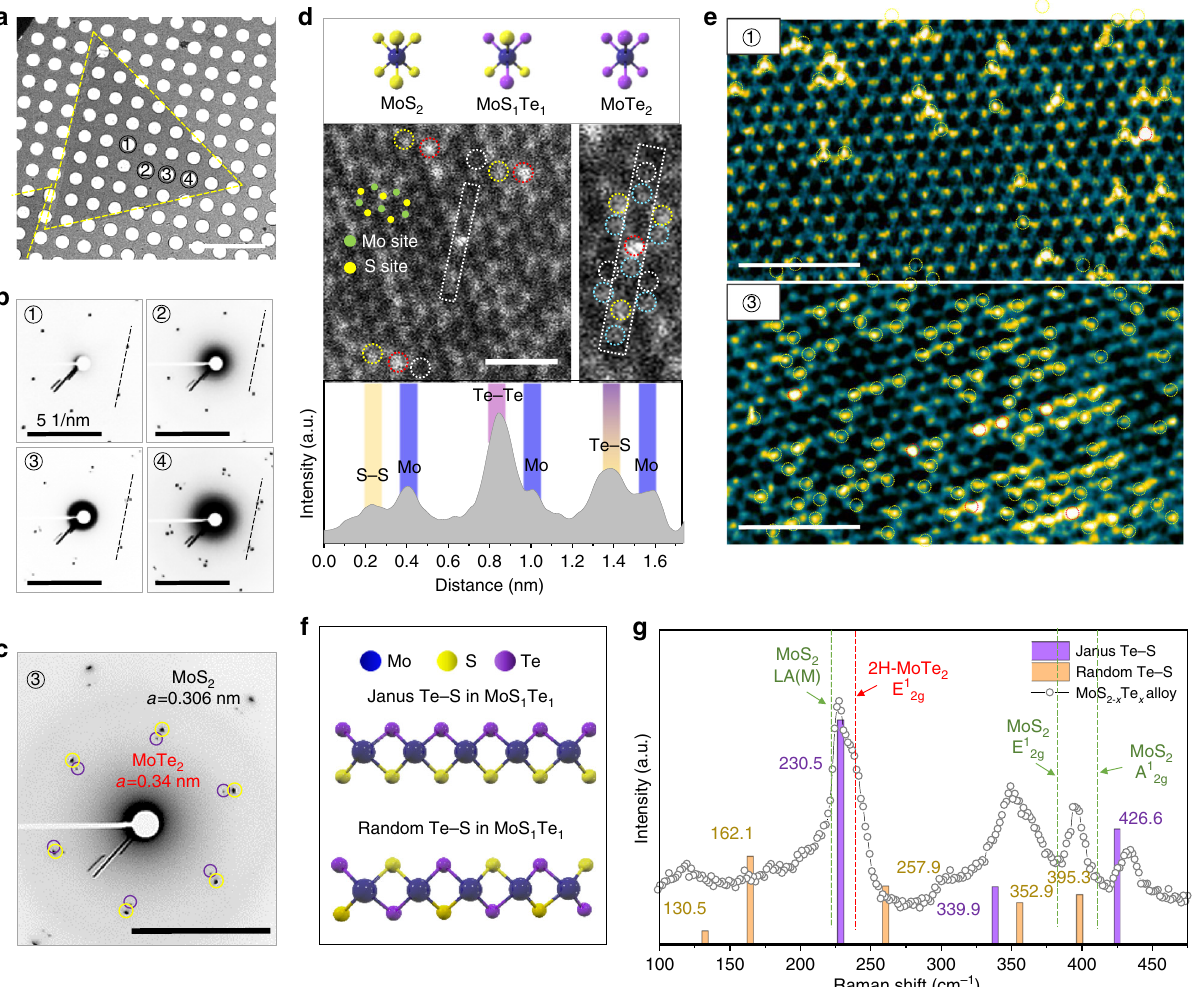
Fig. 3 Atomic structure of monolayer MoS 2 − x Te x with Te – S species. a Low-magni fi cation TEM image of the tellurized MoS 2 fl ake on a 1.2- μ m hole Cu grid; scale bar, 10 μ m. b Electron diffraction pattern from the corresponding positions in ( a ); scale bars, 5 nm − 1 . c Another hexagonal phase emerges from 3, revealing the MoTe 2 phase with a 0.340 nm lattice constant, in addition to MoS 2 with a lattice constant of 0.304 nm; scale bar, 5 nm − 1 . d Schematics for three representative atomic phases of MoS 2 , MoS 1 Te 1 (Te – S), and MoTe 2 . Annular dark fi eld (ADF) STEM image with the corresponding intensity line pro fi le of four species (white circle for S – S, yellow circle for Te – S, red circle for Te – Te, and sky-blue for the Mo site), which is distinguished by brightness; scale bar, 1 nm. e False-color FFT fi ltered images of regions 1 and 3 in a . Te – S and Te – Te in the chalcogen site marked by a yellow and red circle, respectively; scale bars, 2 nm. f Two types of Te – S arrangement in monolayer MoS 1 Te 1 structure. g Analysis of Raman spectrum for MoS 2 − x Te x alloy with calculated vibrational modes of Janus phase and randomly distributed Te – S in monolayer MoS 1 Te